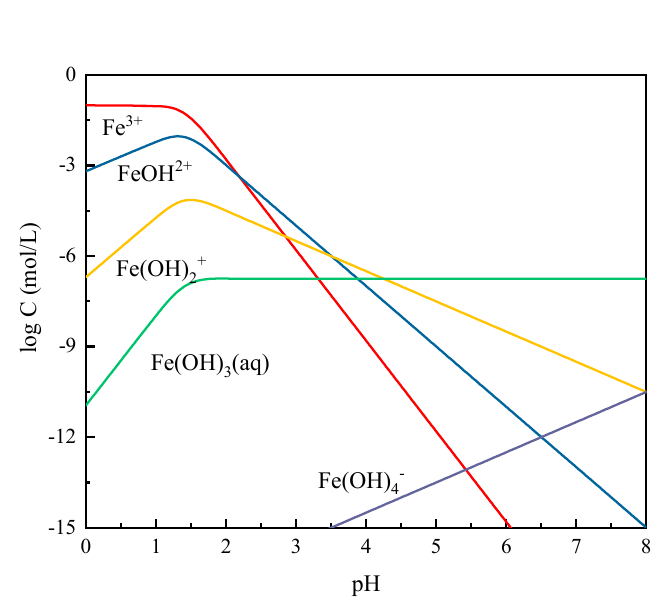
Table 4. Equilibrium reaction and corresponding coefficients of different ions. Ions Reactions